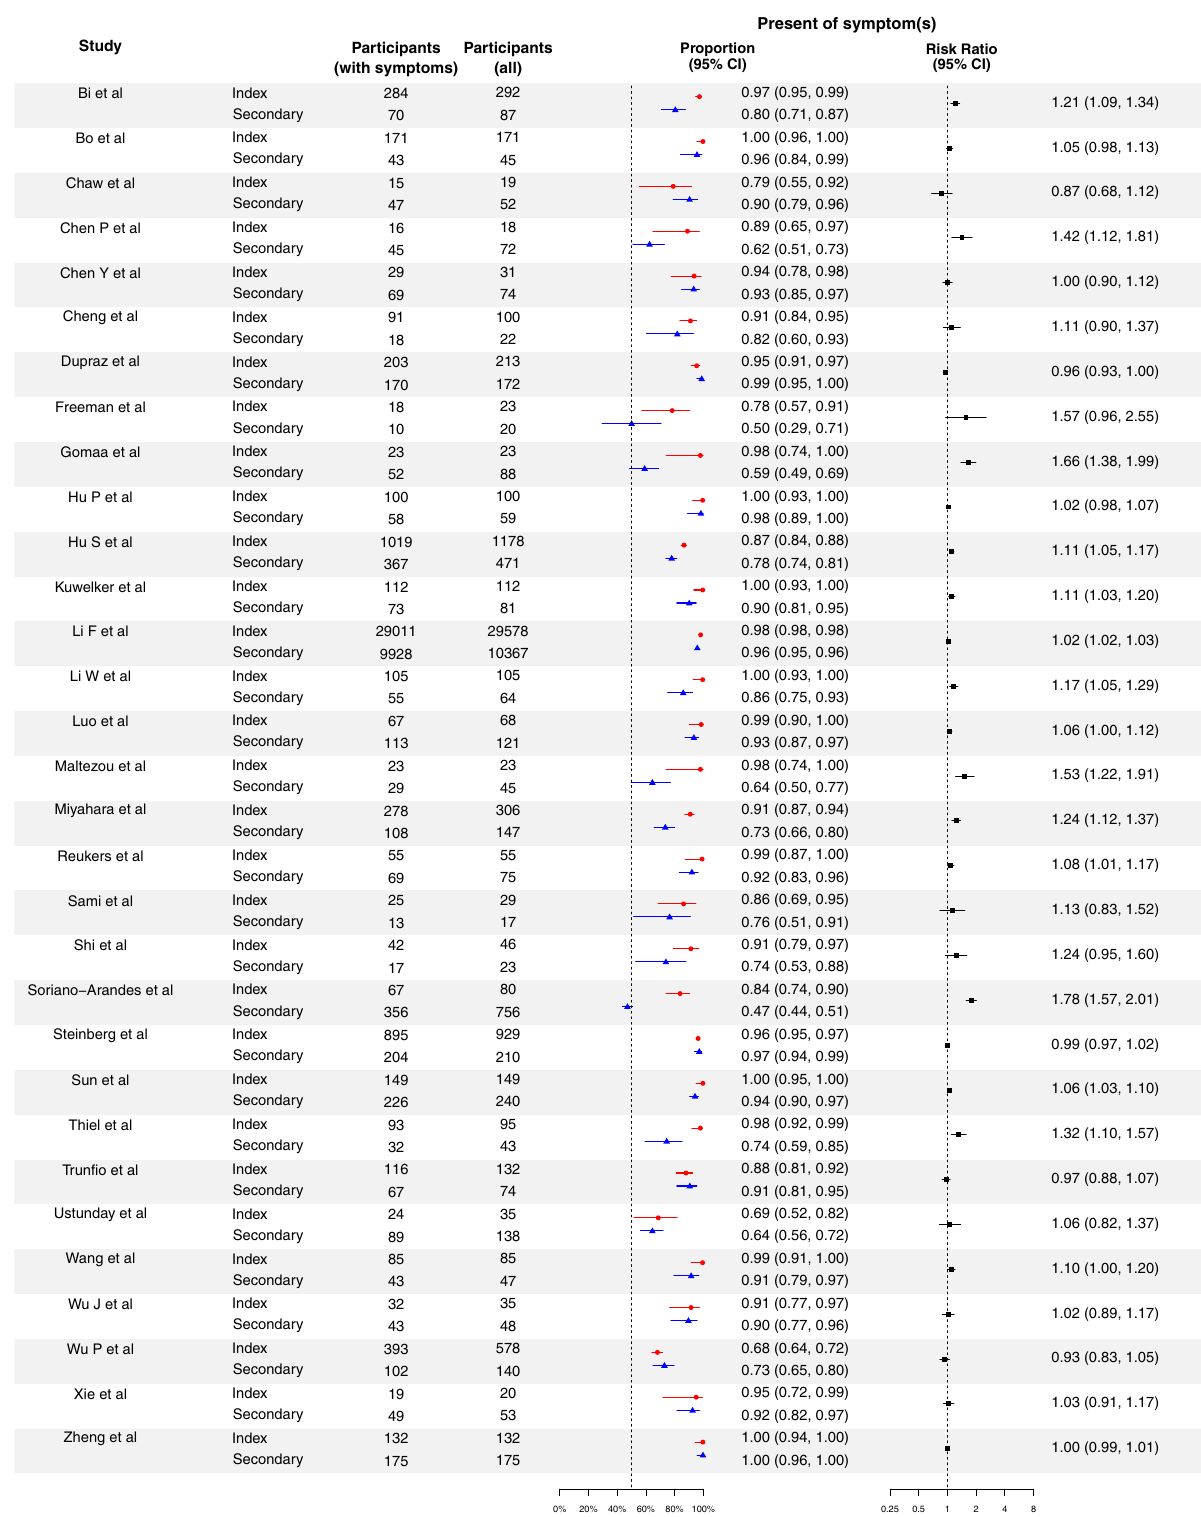
Fig. 4 Proportion of symptomatic cases for the index cases and secondary cases for COVID-19, and their corresponding risk ratio of index cases, compared with secondary cases. Red circles and lines indicate the proportion of fever of index cases and the corresponding 95% exact binomial con fi dence intervals. Blue triangles and lines indicate the proportion of fever of secondary cases and the corresponding 95% con fi dence intervals. Black squares and lines indicate the risk ratio of proportion of fever of index cases compared with secondary cases and the corresponding 95% con fi dence intervals calculated based on normal approximation. All statistical tests are two-sided tests. Adjustments are not made for multiple comparisons.